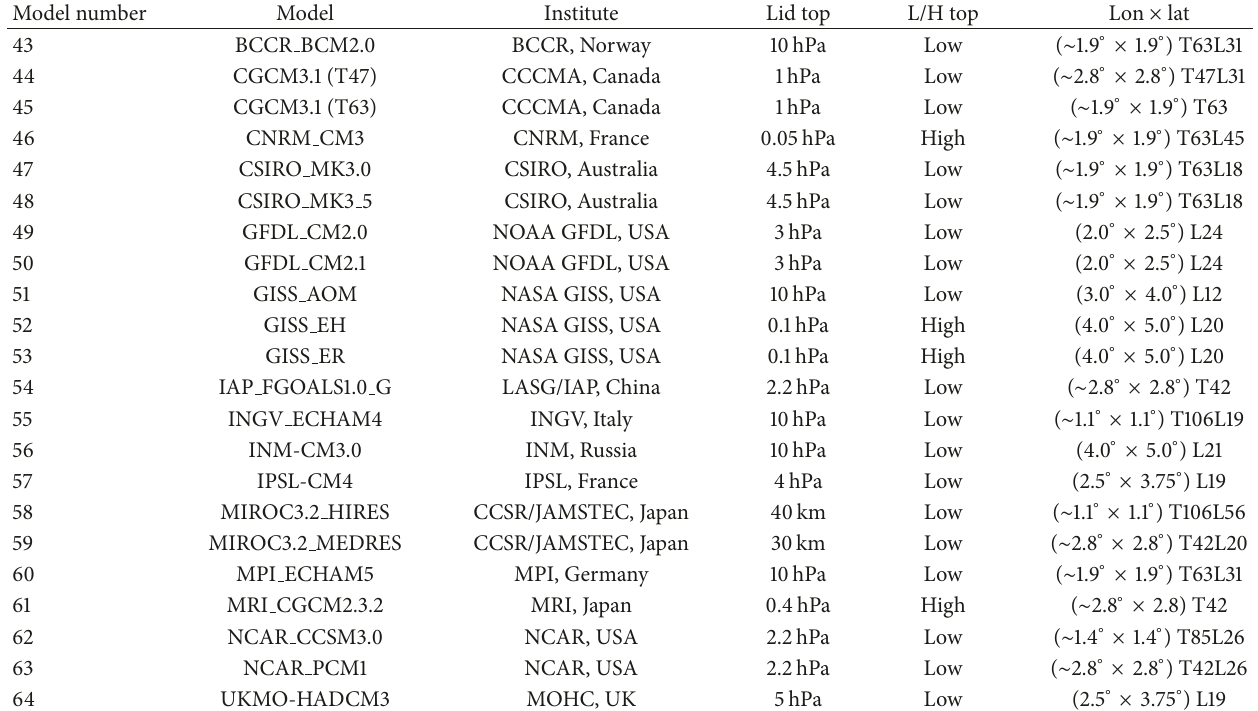
Table 2: Information about the 22 CMIP3 models used in the present